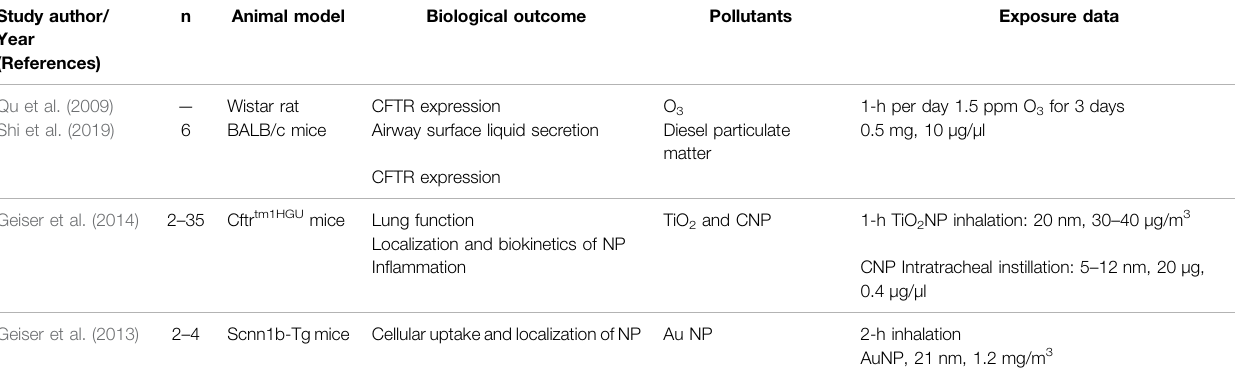
TABLE 2 | In vivo experimental studies.